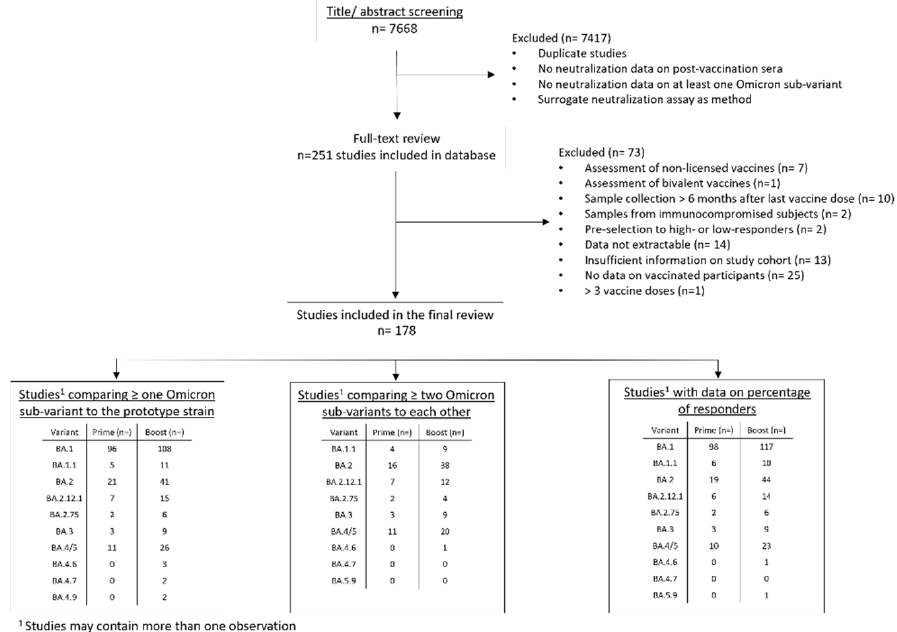
Figure 1. Overview of literature search and study selection process.